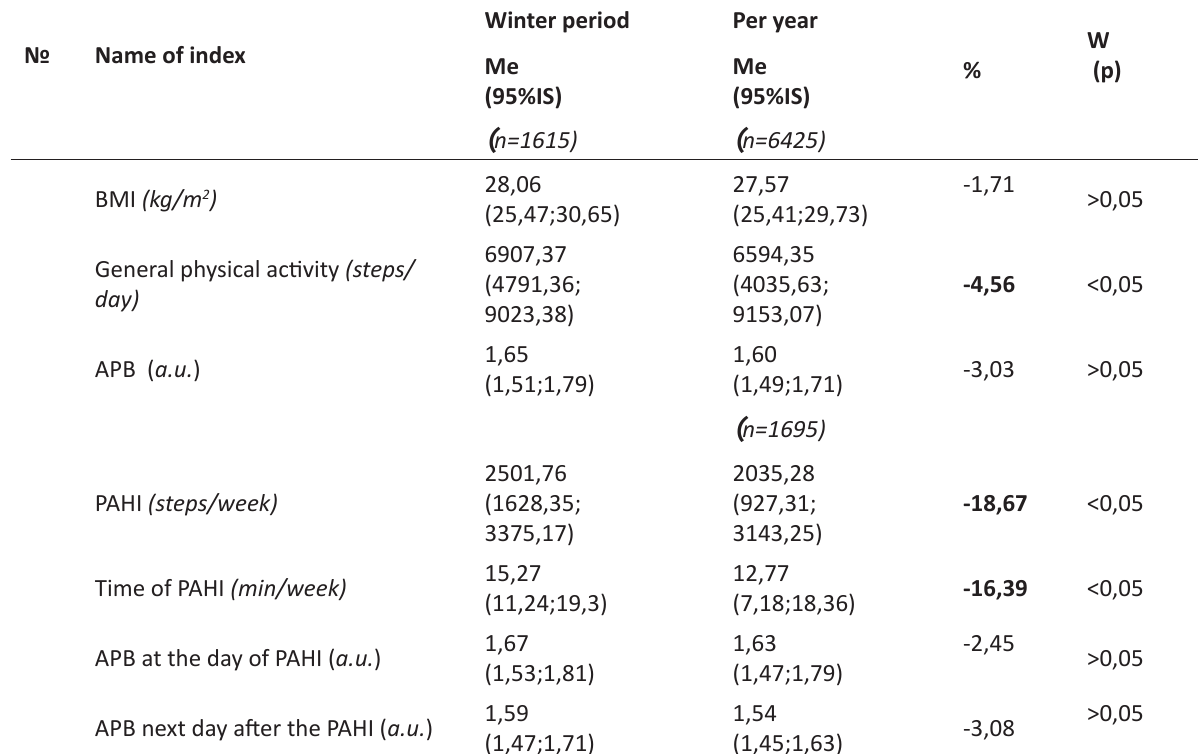
Table 2. Comparison of indicators of physical condition and physical activity of men in spring